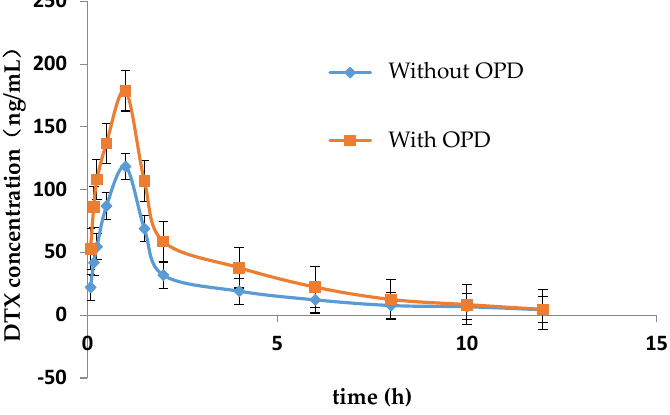
Figure 1. Mean plasma concentration-time curve of DTX in rats with or without OPD ( n = 5).